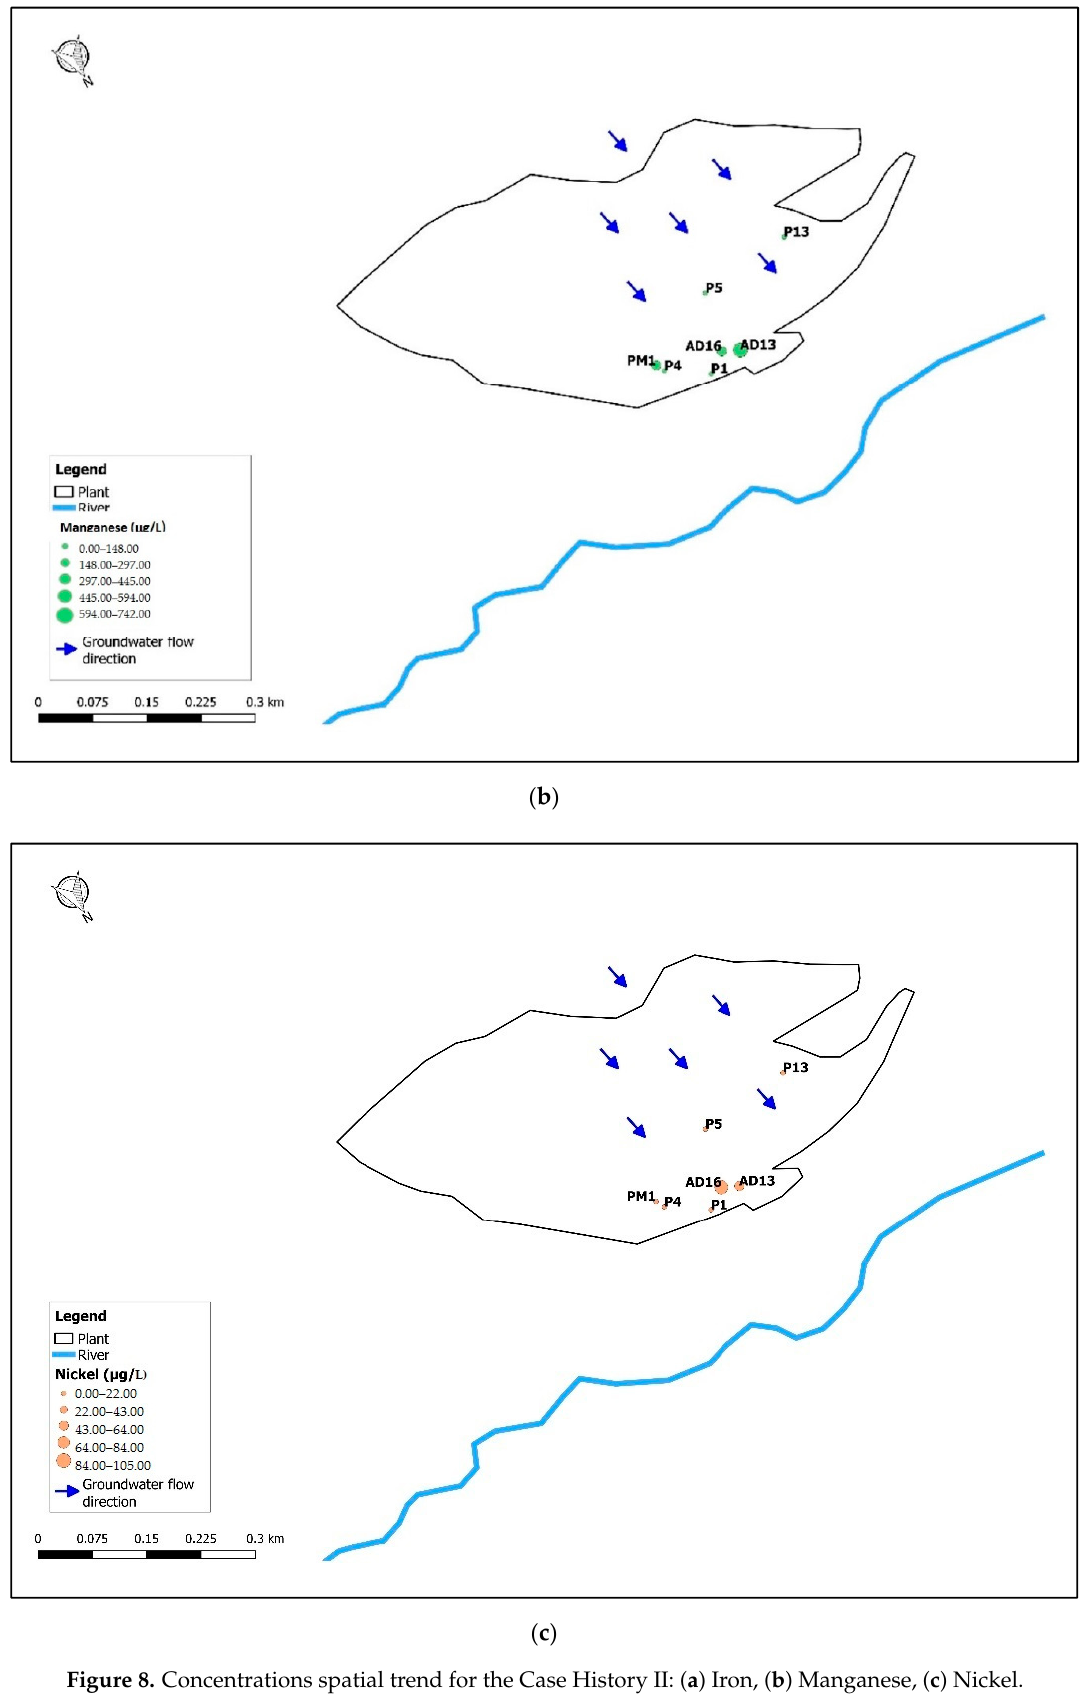
Figure 8. Concentrations spatial trend for the Case History II: ( a ) Iron, ( b ) Manganese, ( c )